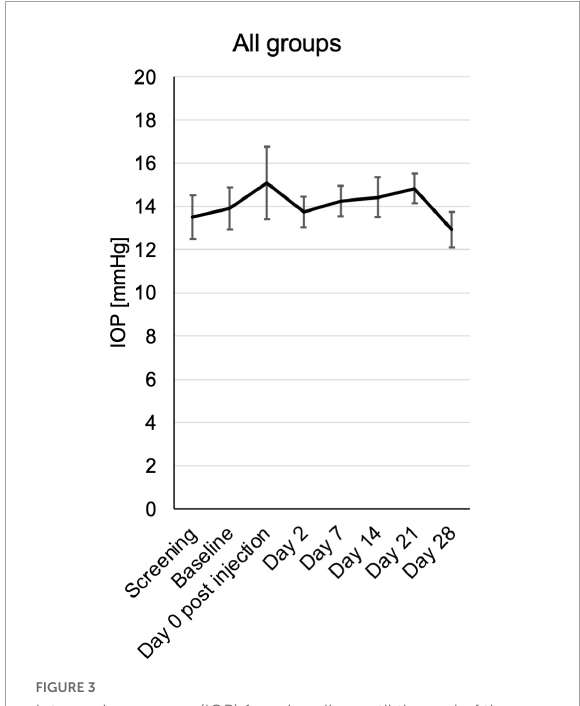
FIGURE3 Intraocular pressure (IOP) from baseline until the end of the study at day 28, assessed at the respective visits. Mean mmHg ± SE is shown for all patients from the different treatment groups.